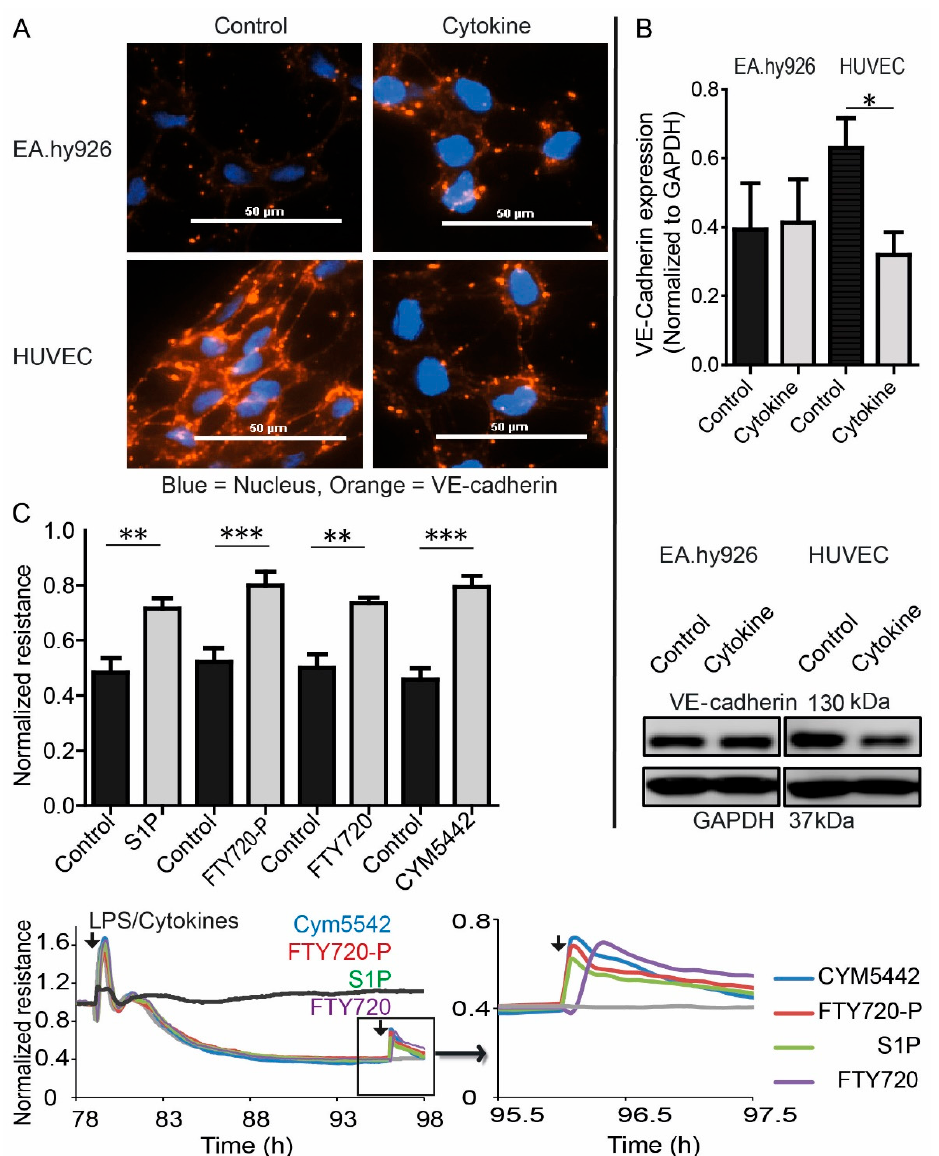
Figure 6. Role of S1P and S1PRs in EC barrier destabilization induced by LPS and cytokines. ( A ) Immunofluorescence staining of VE-cadherin and Western blot analysis of VE-cadherin and GAPDH in EA.hy926 and HUVEC after stimulation with LPS and cytokines or vehicle. Representative images from one out of three individual experiments are shown, size bar = 50 µ m. ( B ) Western blot quantification (top) and representative Western blot (bottom) of VE-cadherin expression in EA.hy926 and HUVEC after stimulation with LPS and cytokines or vehicle, means ± SEM, n = 3, * p < 0.05, determined by two-sided Student’s t-test. ( C ) Resistance following treatment with a mix of LPS and cytokines (50 ng / mL IL1 β , 50 ng / mL TNF α , 1 µ g / mL LPS), and re-stimulated with 1 µ M of the S1PR1 agonist CYM5442, 1 µ M of the S1PR1,3,4,5 agonist FTY720-phosphate and its non-phosphorylated precursor FTY720, and 1 µ M S1P. Line plots represent one experiment out of three with black arrows indicating the addition of stimuli at the corresponding time points. The dark grey line represents an unstimulated control, the light grey line represents a control stimulated with LPS and cytokines without second stimulation. Bar graph represents means ± SEM, n = 3, ** p < 0.01, *** p < 0.001, determined by two-sided Student’s t -test. Normalized resistance values were taken before (controls) and after treatment with S1P, FTY720-P, FTY720, and CYM5442 at the time of the established maximal change of resistance of cells divided by resistance of cells before LPS / cytokine